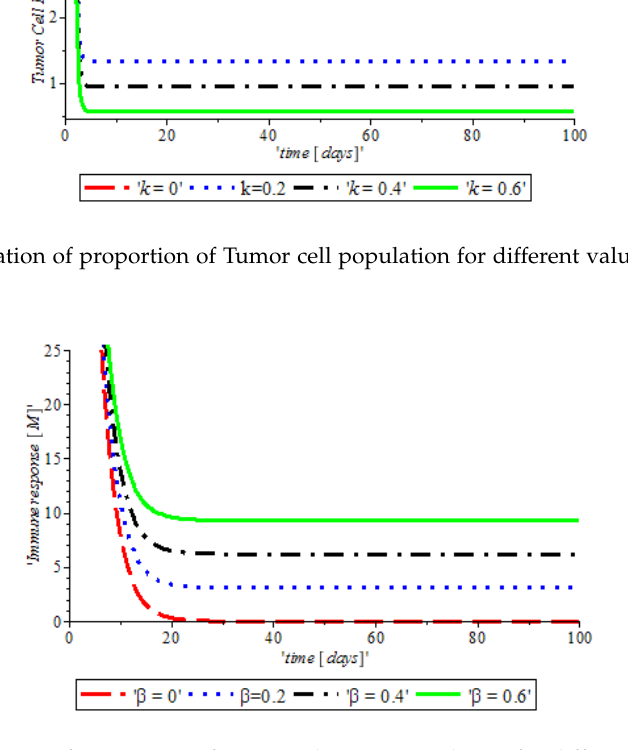
Figure 6. The variation of proportion of Immune booster population for different values of β with other parameters fixed